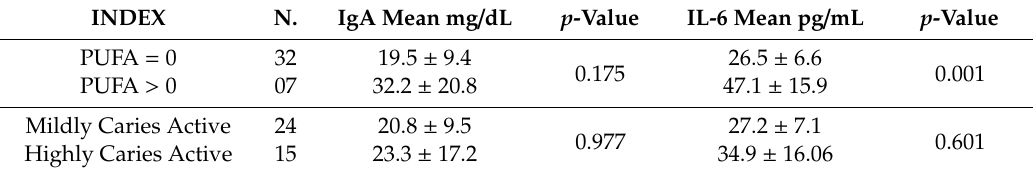
Table 3. B group (39 children). Mean values of DMFT, PUFA, s-IgA (mg / dL), and IL-6 (pg /